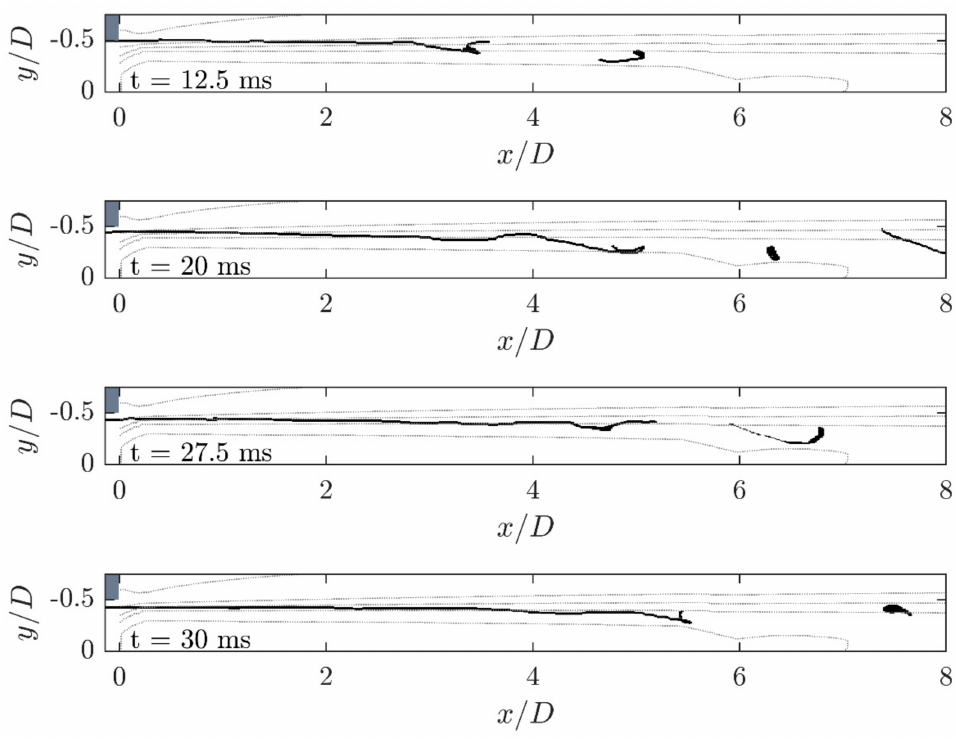
Figure 10. Visualization of a time series showing the droplet break-up by Kelvin-Helmholtz